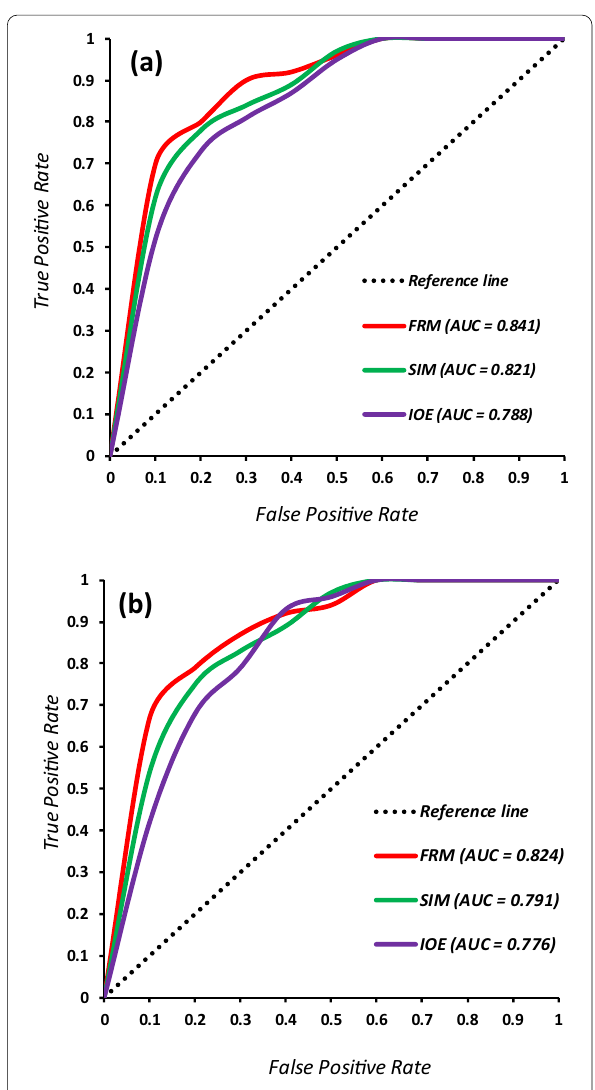
Fig. 8 AUC for methods performance Al‑Balouta river basin: a prediction rate curves of the landslide susceptibility models used, b success curves of the landslide susceptibility models utilized